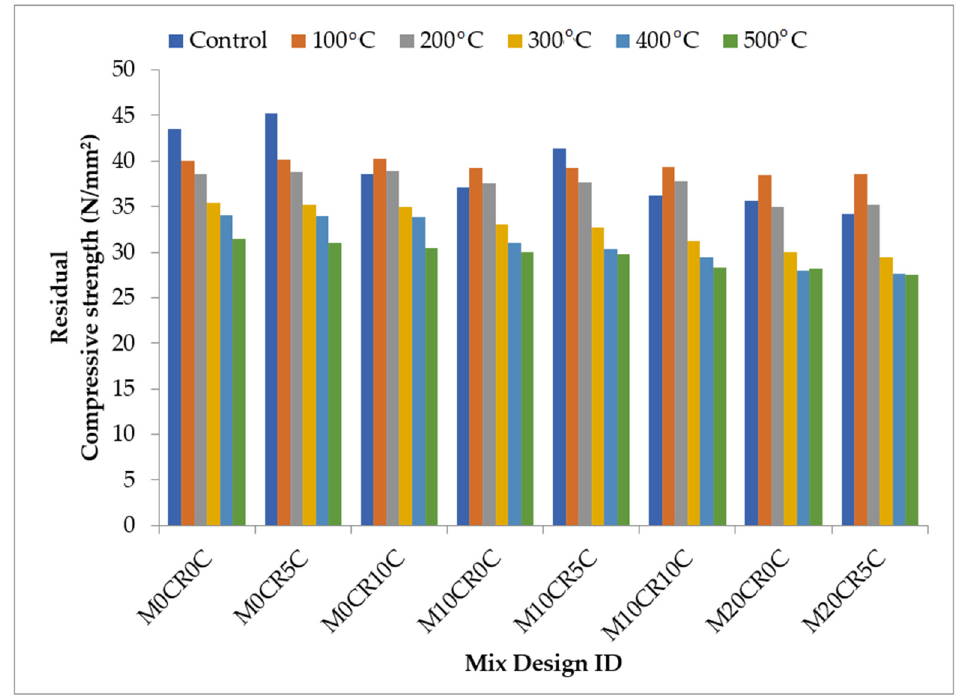
Figure 9. Effect of elevated temperature on the compressive strength of SCC mixes containing CR and CCW.